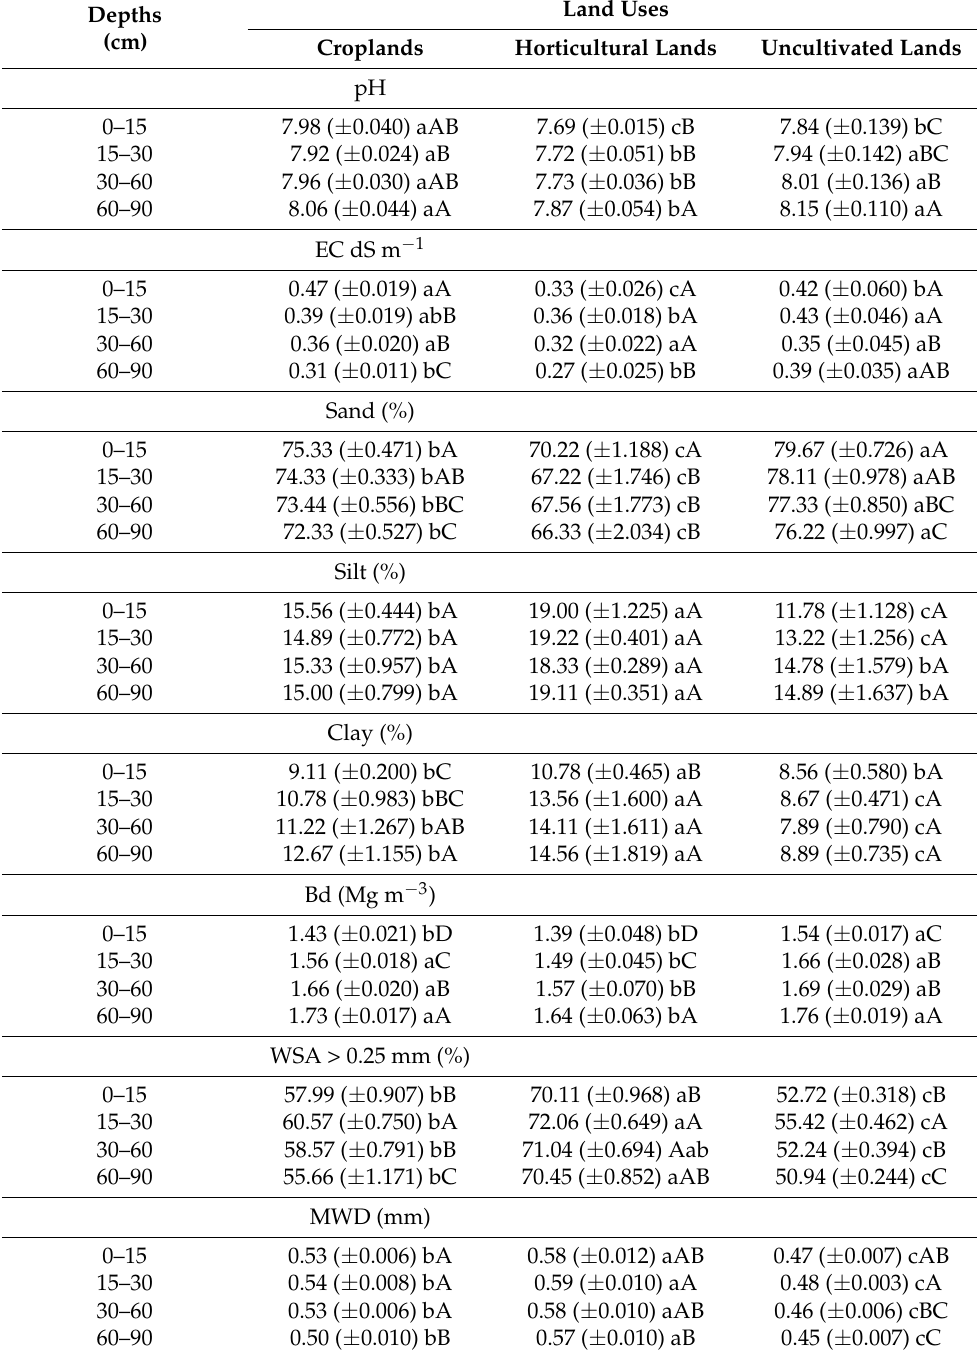
Table 3. Depth-wise variation of soil physicochemical parameters under different studied land uses in south-western Punjab,